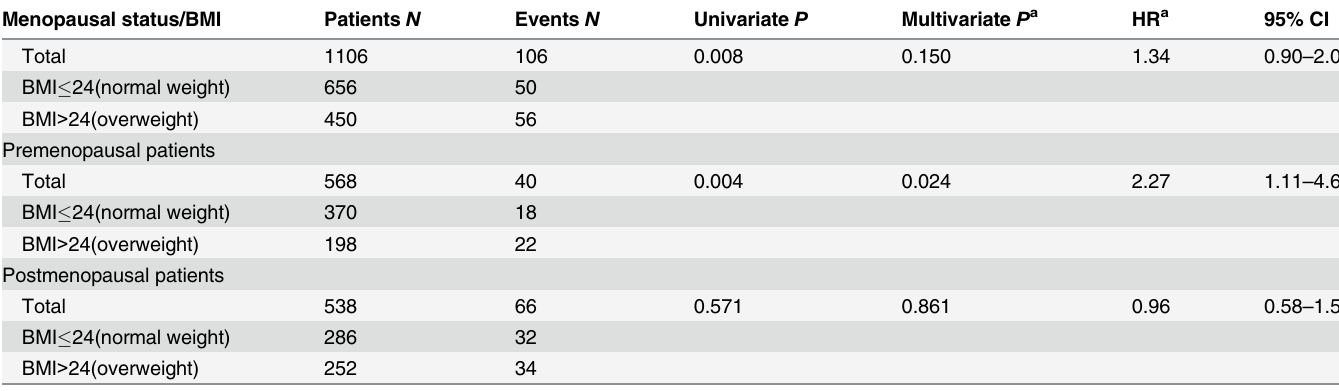
Table 3. Univariate and multivariate BCSS analysis of BMI in TNBC patients according to menopausal status.